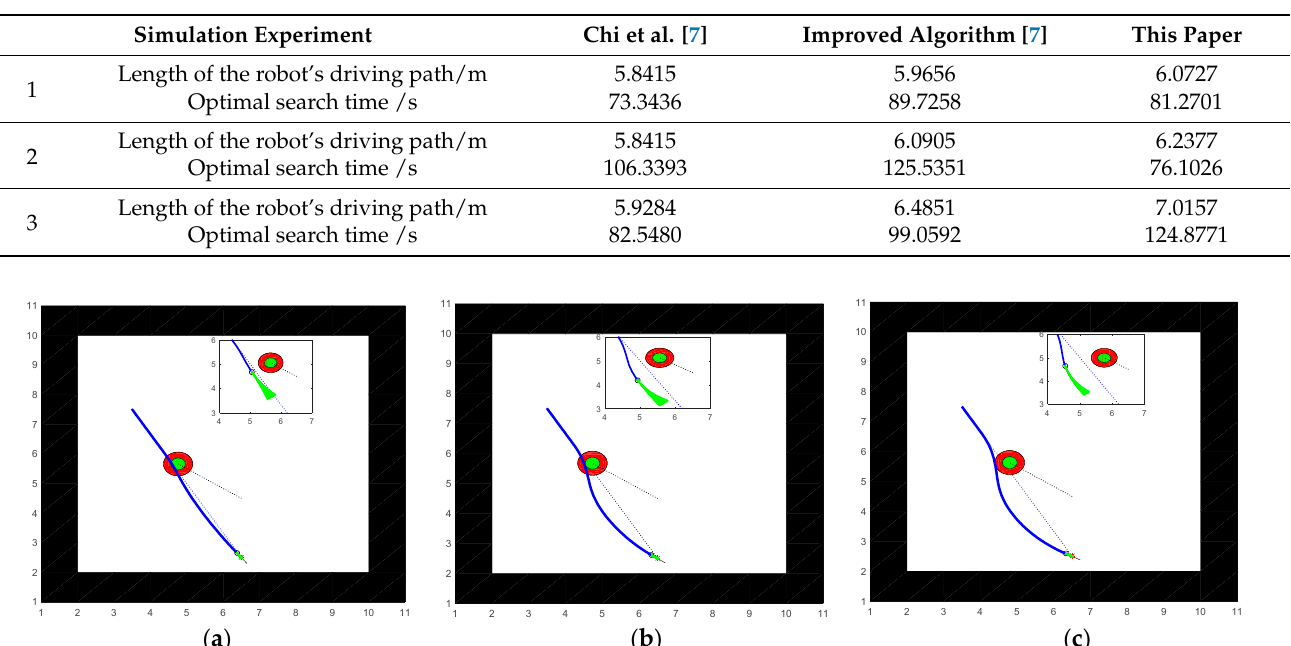
( c ) Figure 23. Comparison of path planning results for unknown dynamic environment 3; ( a ) Chi et al. [7]; ( b ) Improved algorithm [7]; and ( c ) This paper. 6.3.3. Complex Dynamic Environments The above experiments have verified the effectiveness of IACO global path planning and the obstacle avoidance capability of IDWA. This simulation further demonstrates the dynamic obstacle avoidance feasibility of the fusion algorithm in complex environments by setting up different levels of unknown complex environments, illustrated by a simula- tion example below. In this example, firstly, a static environment for the robot is established in a 40 × 40 grid environment, and the optimal global path with a path length of 55.5667m from the starting point (1.5, 40.5) to the endpoint (40.5, 1.5) is planned based on IACO, as shown by the black dashed line in Figure 24. Next, setting unknown dynamic obstacles in this environment, the robot moves along the global path, judges the surrounding environment in real-time, and avoids obstacles according to their conditions. The experimental results are shown in Table 9 and Figures 24–26, and due to the difference in computer perfor- mance, the algorithm running time does not represent the actual robot movement time. In this case, the number of control nodes of the robot represents its motion time, and every ten nodes simulate 1s in natural environments. Table 9. Comparison table of robot paths. Path Length/m